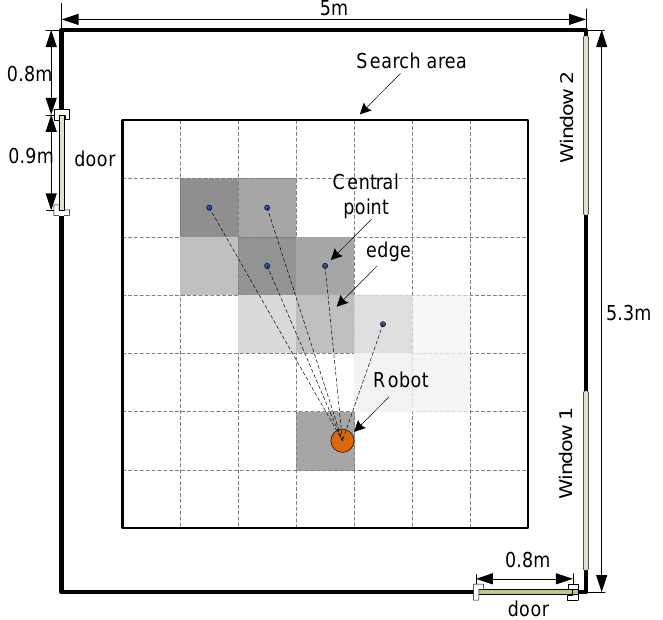
Figure 1. Discretization of the CPT searching environment. The search area is divided into a number of grids. The gray-scale of each grid represents the pheromone value deposited into that grid. Darker color indicates higher pheromone value. The straight dashed lines connecting the robot and the central points are interpreted as edges in the traditional ACO. The robot performing the adapted ACO strategy chooses one of the central points as its temporary goal and moves toward